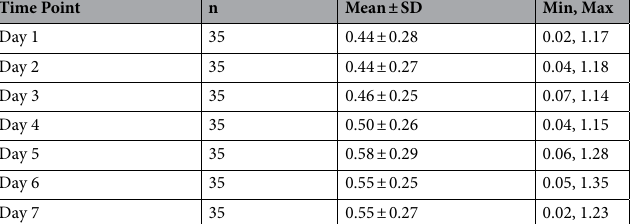
Table 2. Amount of Vuse Solo e-liquid used per day (g) over the 7-day study period among 35 subjects randomized to Vuse Solo group. N total number of subjects randomized to Vuse Solo group, n number